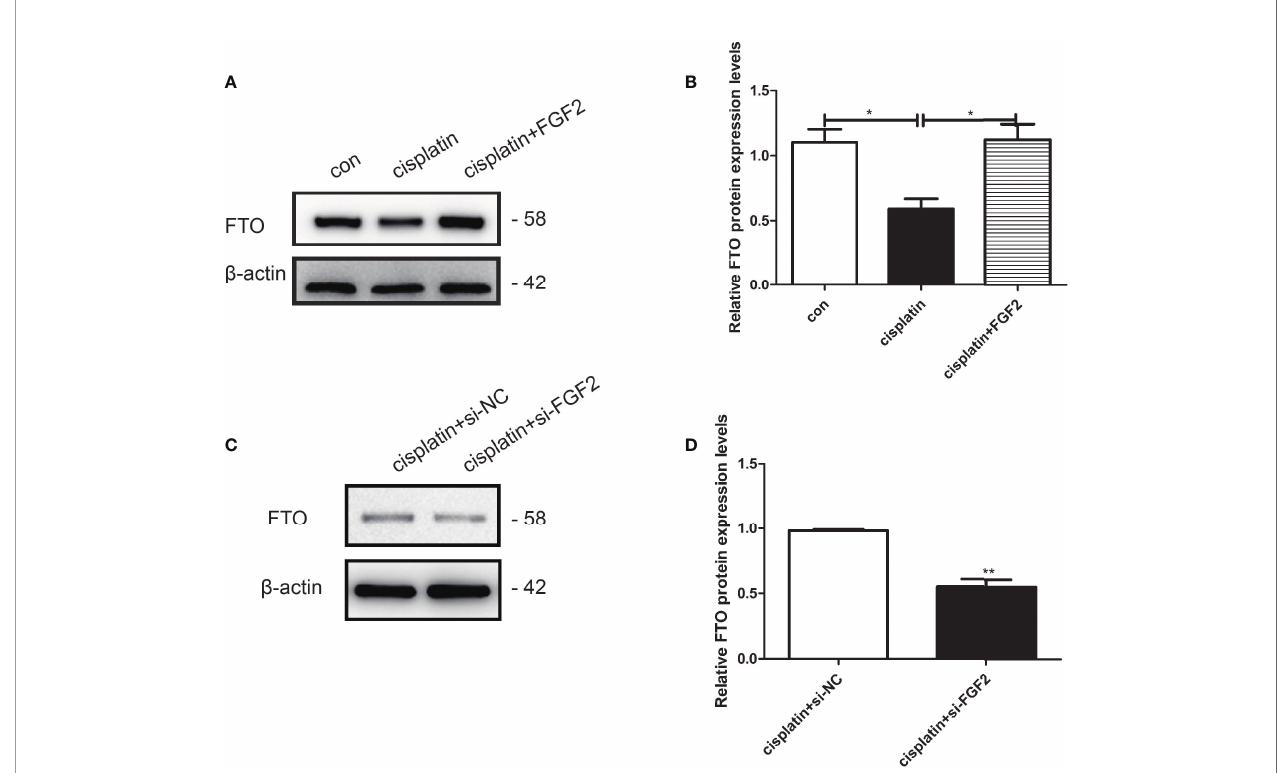
FIGURE 6 | FGF2 facilitated the expression of FTO in injured KGN cells. (A, B) Western blot indicated that exogenous addition of FGF2 into injured KGN cells resulted in upregulation of FTO than those of injured cells. One-way ANOVA followed by Tukey ’ s multiple comparison test. The results were shown as mean ± SEM from three independent experiments ( a = 0.05, * P < 0.05). (C, D) Western blot indicated that transient transfection of si-FGF2 resulted in downregulation of FTO in injured KGN cells when compared to those transiently transfected with si-NC. Student ’ s t-test. The results were shown as mean ± SEM from three independent experiments ( a = 0.05, ** P <